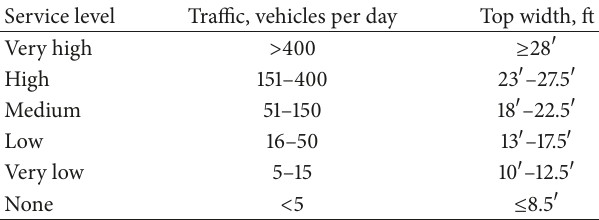
Table 3: Service level of county unpaved